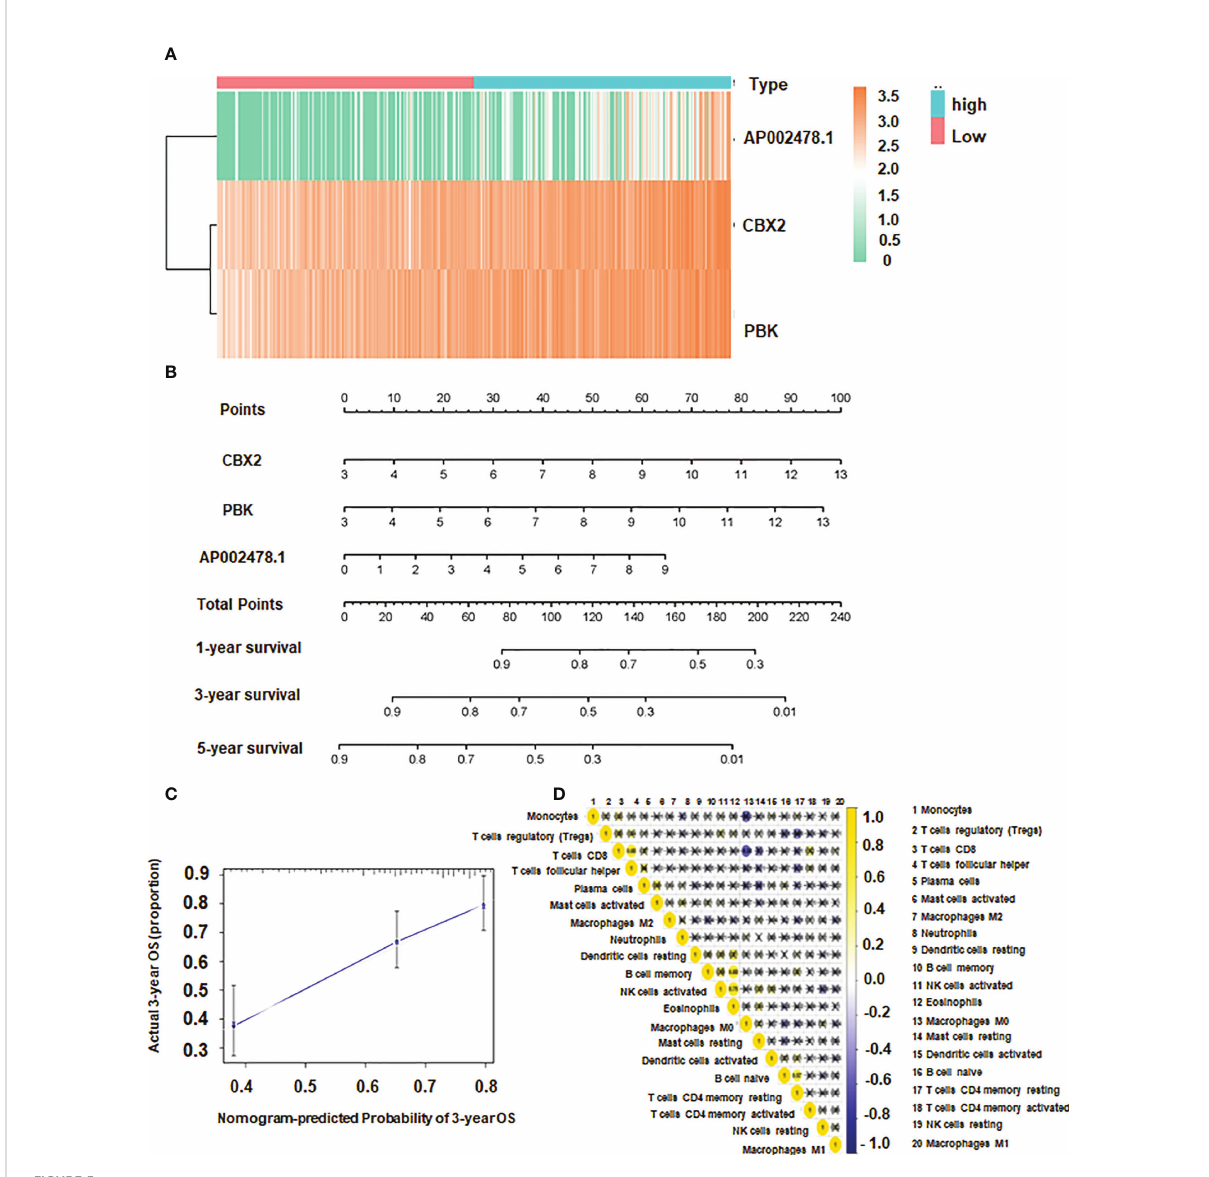
FIGURE 5 The association of CBX2, PBK, AP002478.1 and survival. (A) Heatmap of differentially expressed genes. (B) Nomogram based on multiple Cox regression. (C) Calibration curve for 3-year survival. The closer to the diagonal, the better the prediction effect. (D) Co-expression patterns among fractions of immune